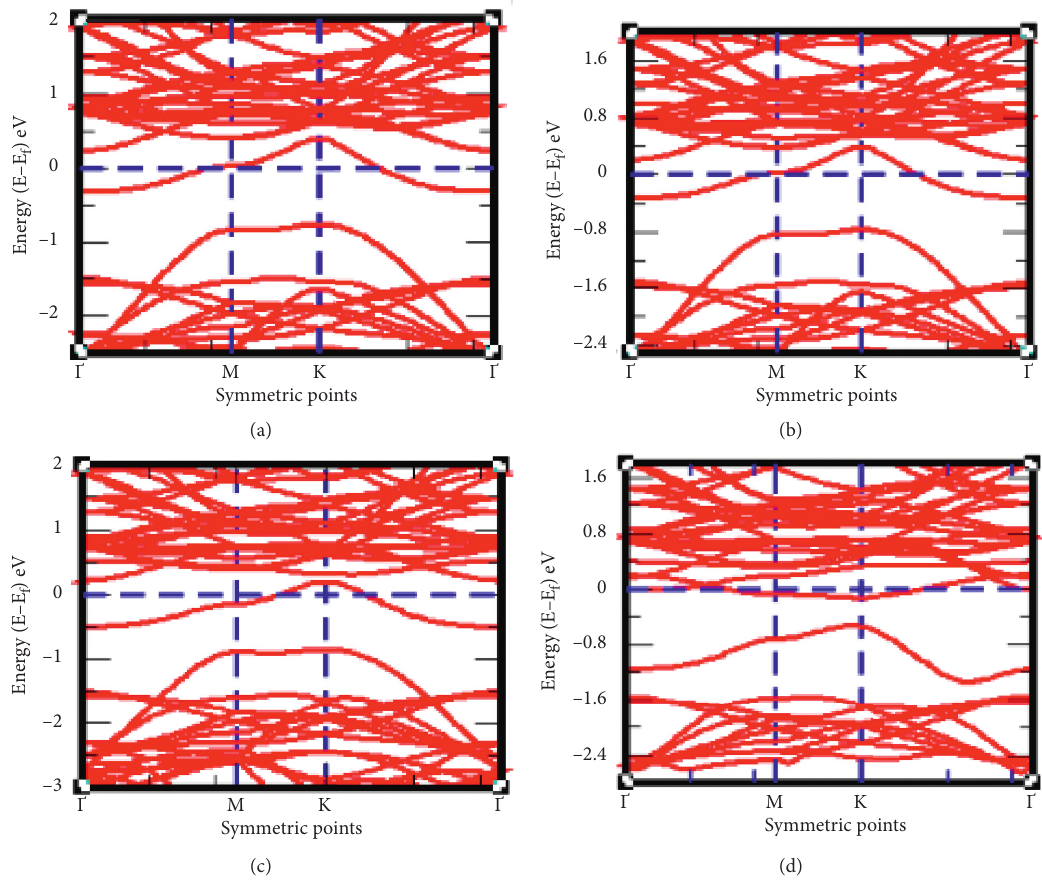
Figure 4: (a) Band structure of R-1C atom vacancy defects in HS-G/MoS 2 , (b) band structure of L-1C atom vacancy defects in HS-G/MoS 2 , (c) band structure of C-1C atom vacancy defects in HS-G/MoS 2 , and (d) band structure of 2C atom vacancy defects in HS-G/MoS 2 , where the horizontal dotted line represents Fermi